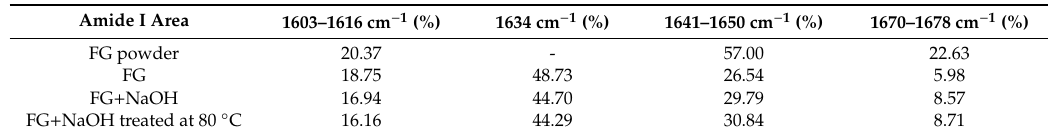
Table 1. Resulting percentage of the curve fitting of amide I for FG powder, FG, FG+NaOH, and thermal treated FG+NaOH electrospun mats.